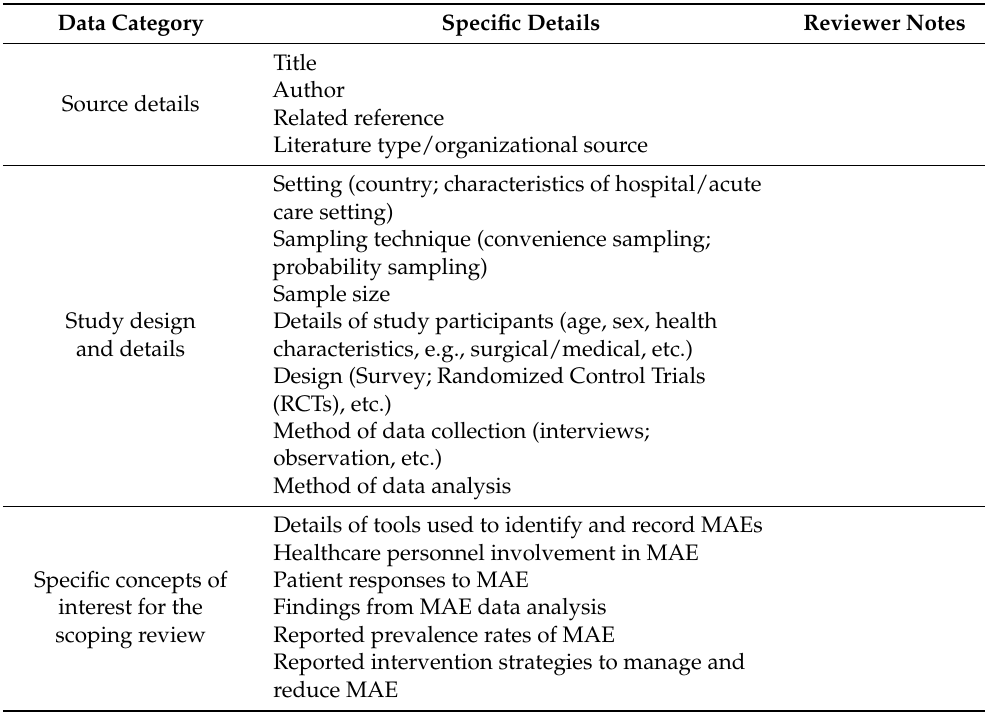
Table A3. Data Extraction Tool for Unpublished